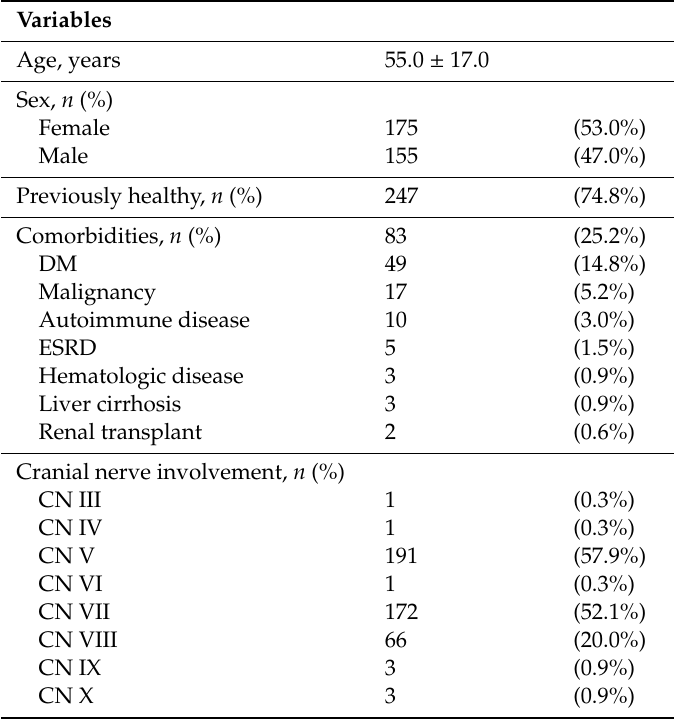
Table 1. The demographics in 330 patients with cranial nerve zoster.